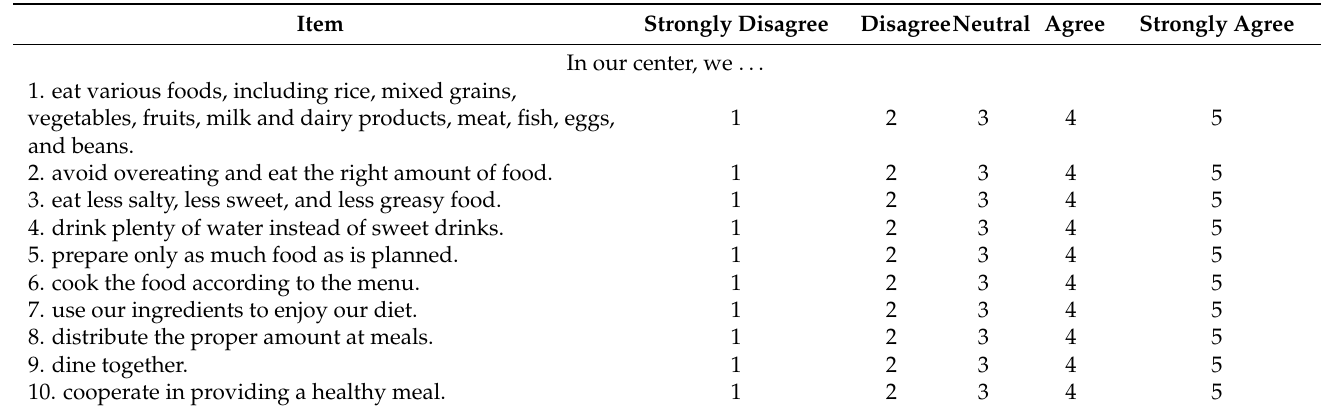
Table A1. The original version of the questionnaire to identify CCC healthy eating practice.